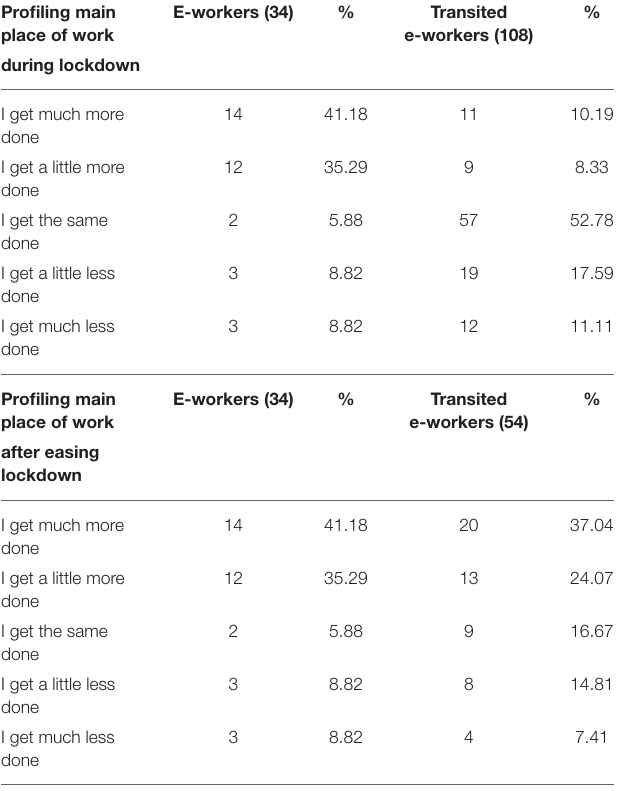
TABLE 5 | Working at home preferences after social distancing. Working at home preferences after social distancing